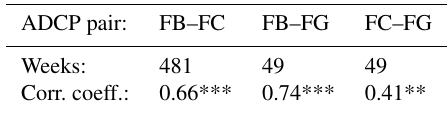
Table 2. Correlations between weekly averaged along-channel ve- locities at the shallowest measured level and a level 200m deeper for four ADCP sites, using the longest ranging deployment at each site of at least 11 months duration. “Weeks” indicates the number of values for each correlation. The last row lists the regression co- efficient, a , in the equation: U deep = a · U shallow + b .